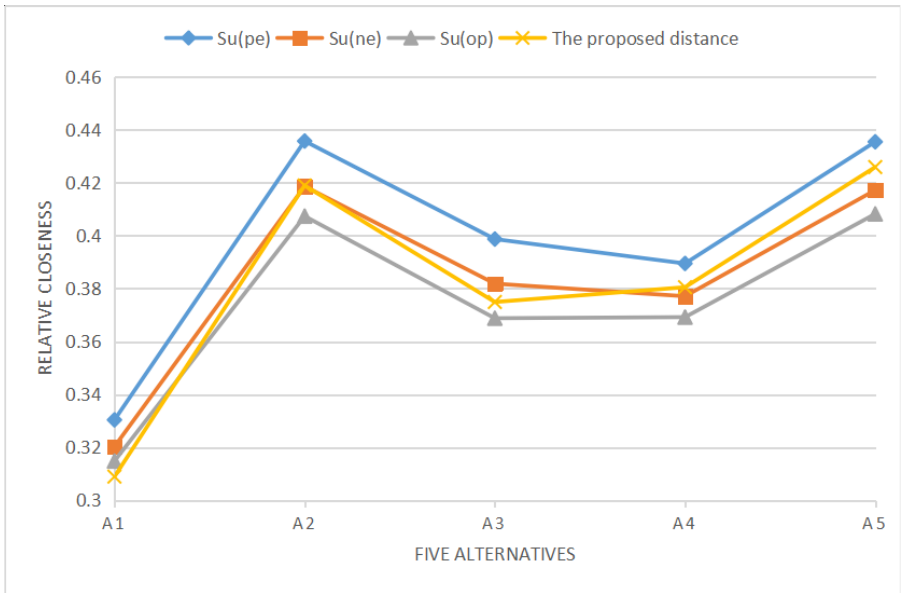
Figure 2. Relative closeness derived from different distance